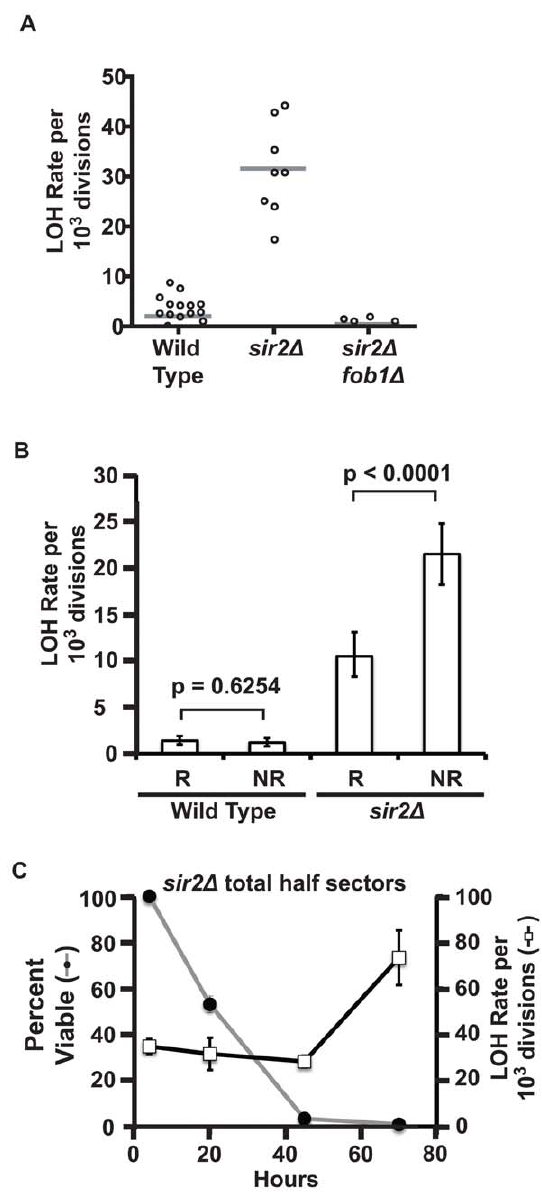
Figure 7. Characterization of LOH events in young sir2 D cells. A) Scatter plots of total LOH rates at the MET15 locus in young cells with genotypes as indicated. B) Rates of total LOH events at MET15 in young cells for wild type (UCC5185) and sir2 D (UCC8836) strains. Rates of reciprocal/non-reciprocal events were significantly different in the sir2 D strain but not in wild type (Fisher’s exact test by contingency tables, p values indicated above columns). C) Rates of total LOH events at MET15 in replicatively aging sir2 D cultures. Right y-axis: LOH rates at MET15 (open boxes) reported as total LOH events per cell division. Error bars indicate SEM. Left y-axis: Percent viability of mother cells in the aging culture (grey line).